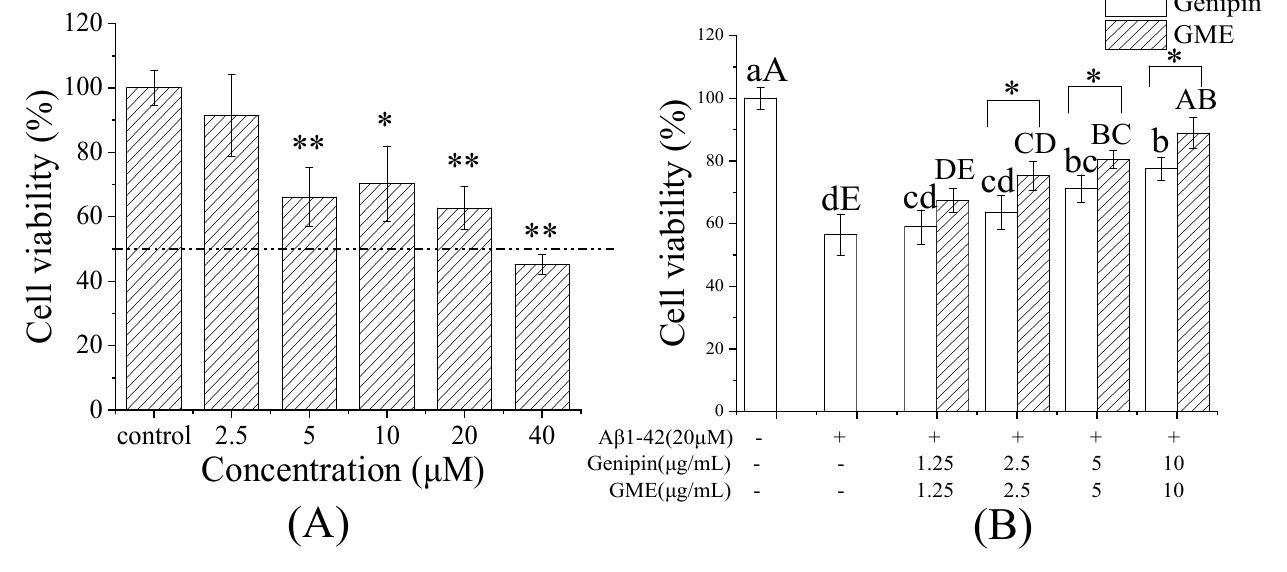
Figure 8. Neuroprotective effect of GME. A β 1-42 damage concentration ( A ), and the effect of free genipin and GME ( B ). Different letters (a,b,c,d) indicate a significant difference in the Genipin